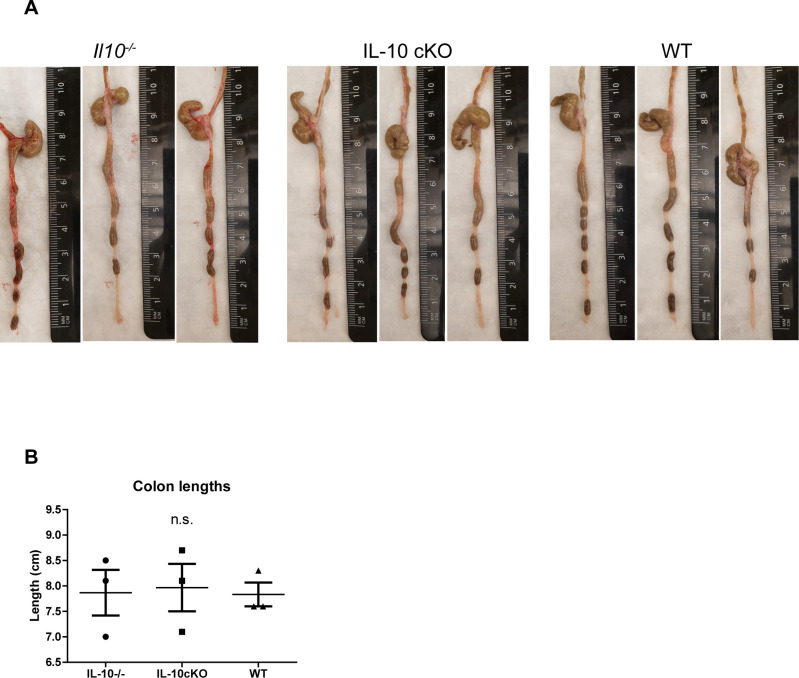
Colon lengths of conditional and global Il10 knockout mice.(A and B) Mouse colon photographs and their lengths as measured by the distance between anus (at 0) and cecum.